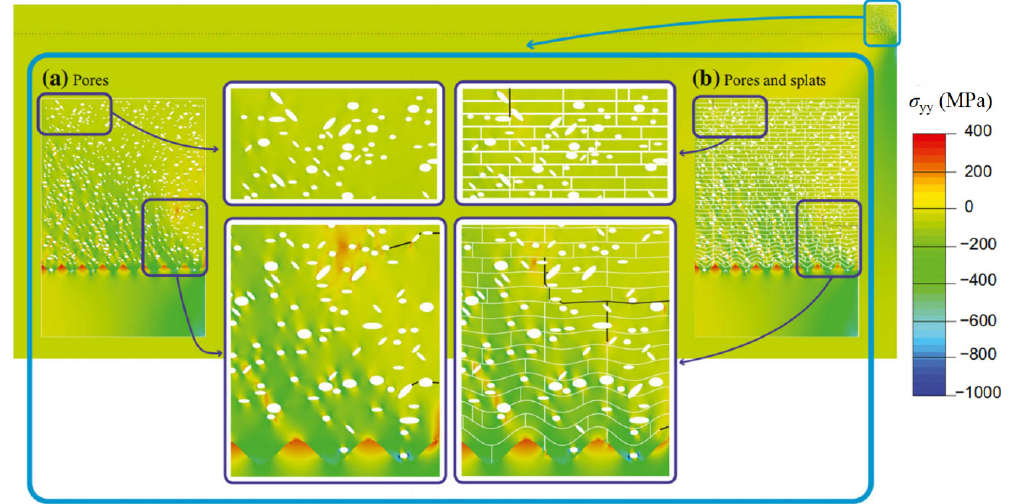
Fig. 26 Stress state and crack behavior at room temperature in different models: (a) pore model and (b) splat model. Reproduced with permission from Ref. [135], © The Author(s)